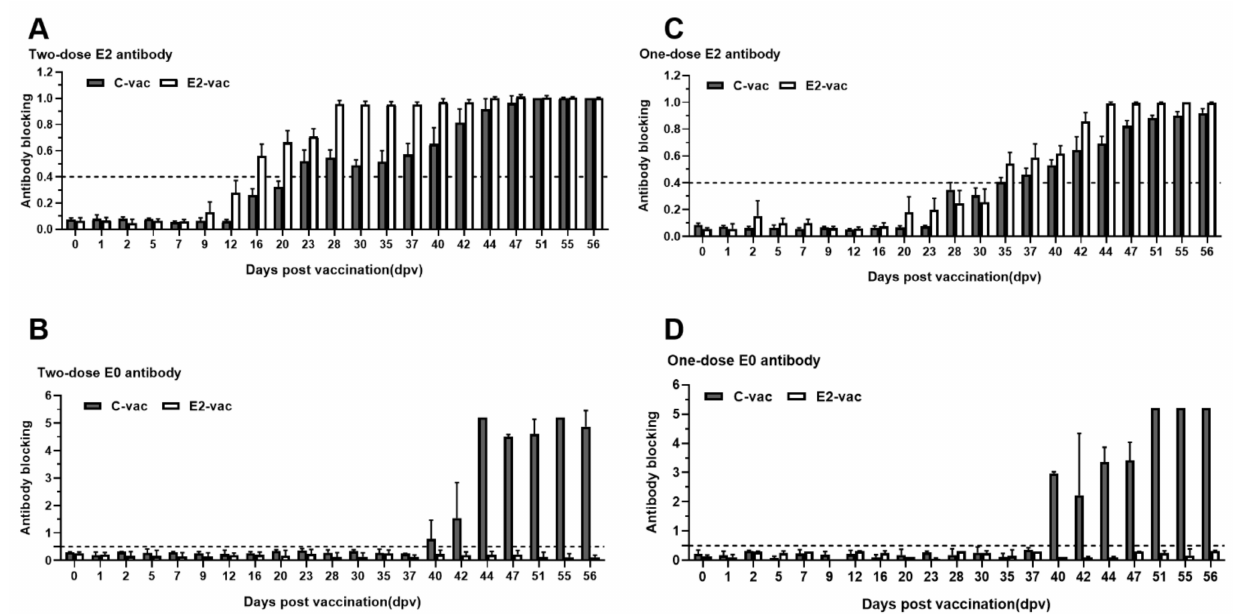
Figure 3. Antibody responses in pigs in the two-dose ( A , B ) and one-dose ( C , D ) vaccination groups according to the blocking ELISAs. Gray columns represent the ELISA blocking rate of the C-vac groups, and white columns represent the ELISA blocking rate of the E2-vac groups. The dotted line represents a positive threshold: E2 > 0.4, E0 > 0.5, NS3 >